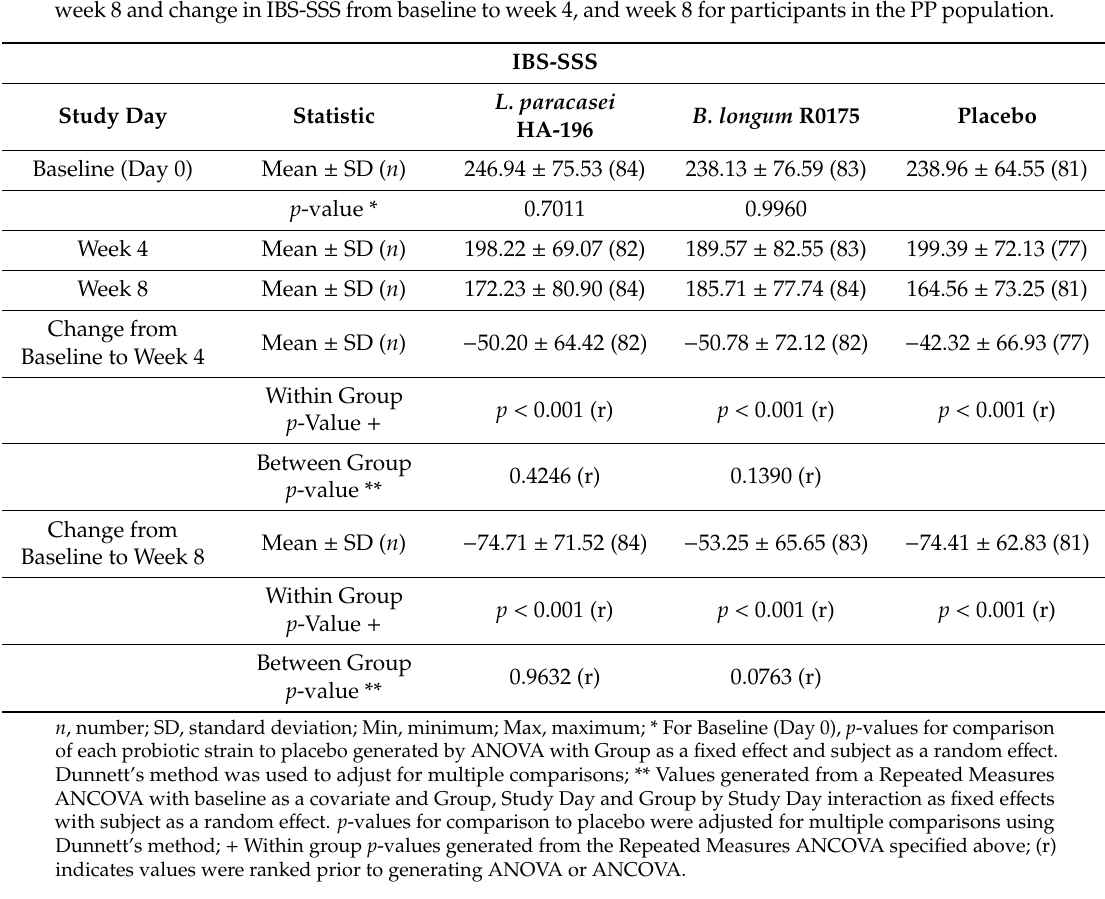
Table 2. Irritable Bowel Syndrome Symptom Severity Scale (IBS-SSS) score at baseline, week 4, and week 8 and change in IBS-SSS from baseline to week 4, and week 8 for participants in the PP population.